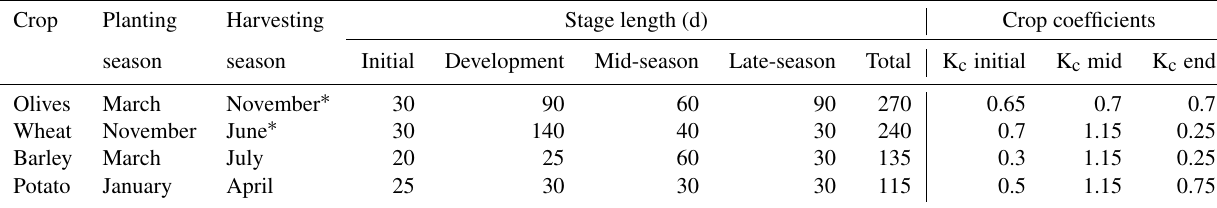
Table 4. Crop planting and harvesting seasons, stage length, and crop coefficients. Crop Planting